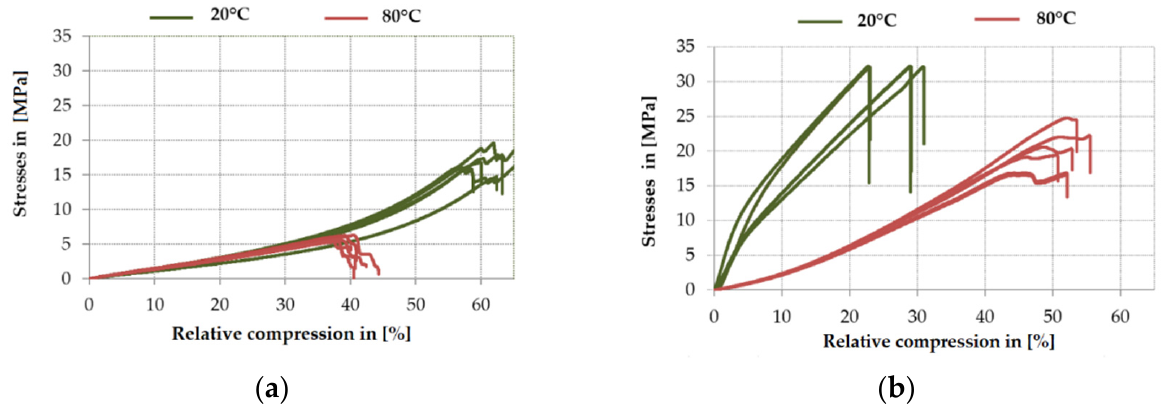
Figure 7. Impact of the test temperature on the stress and limit deformation in the compression test: ( a ) for PS; ( b ) for EP 2579-1.